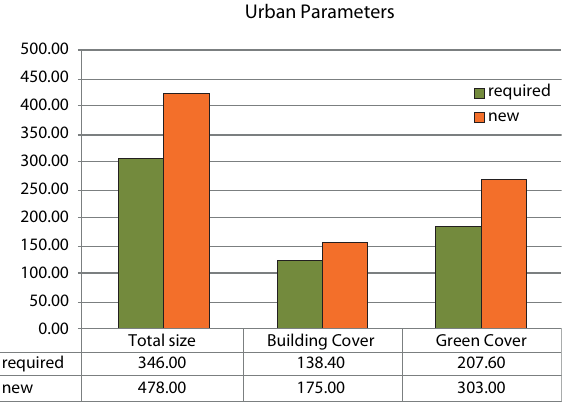
fig. 15. Planting requirement and